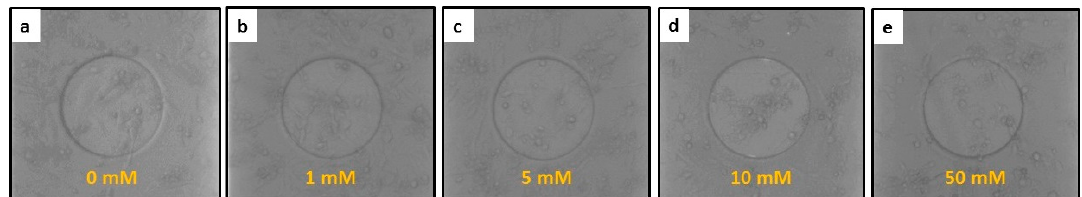
Figure 2. Images of live and dead hFOB 1.19 cells on microfabricated electrodes after treatment with different concentrations of MgO nanoparticles (NPs) at 24 h: ( a ) 0 mM MgO NPs (control group); ( b ) 1 mM MgO NPs; ( c ) 5 mM MgO NPs; ( d ) 10 mM MgO NPs; and ( e ) 50 mM MgO NPs. Appl. Sci. 2018 , 8 , x